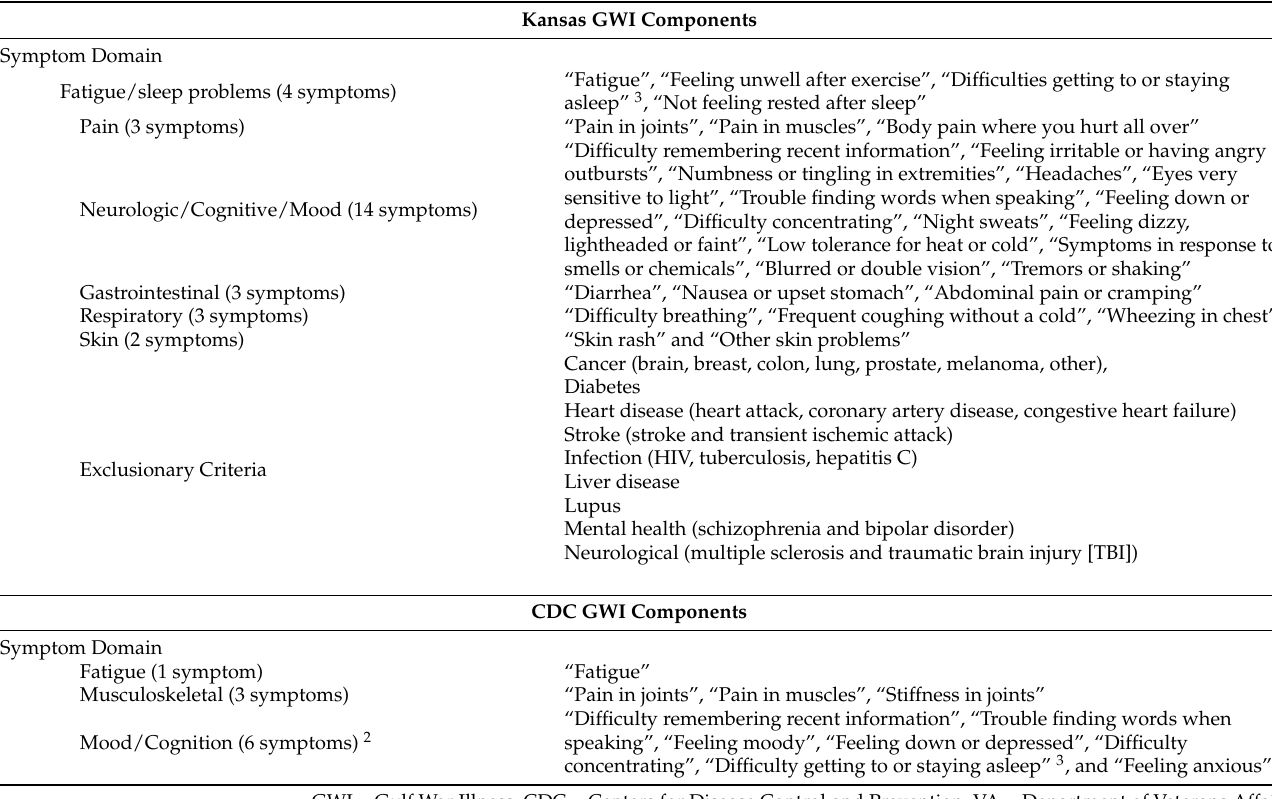
Table A1. Kansas GWI and CDC GWI Components 1